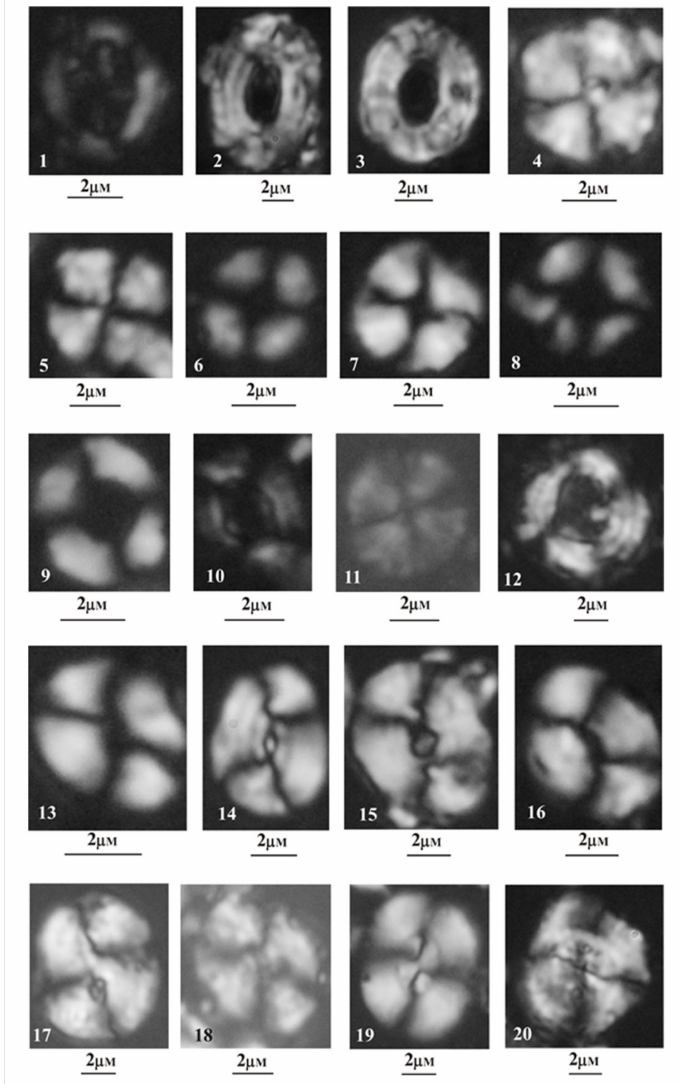
Figure 4. Jurassic species of the Warte section. Abbreviation ‘pol’ denote polarized